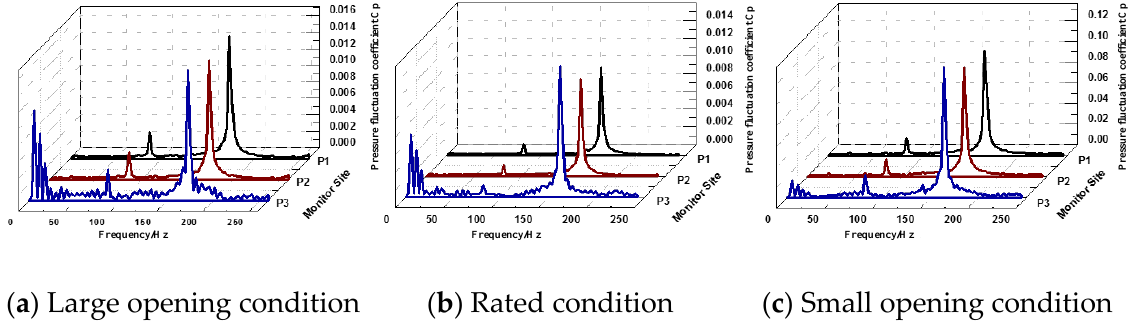
Figure 8. Runner pressure pulsation frequency domain diagram.